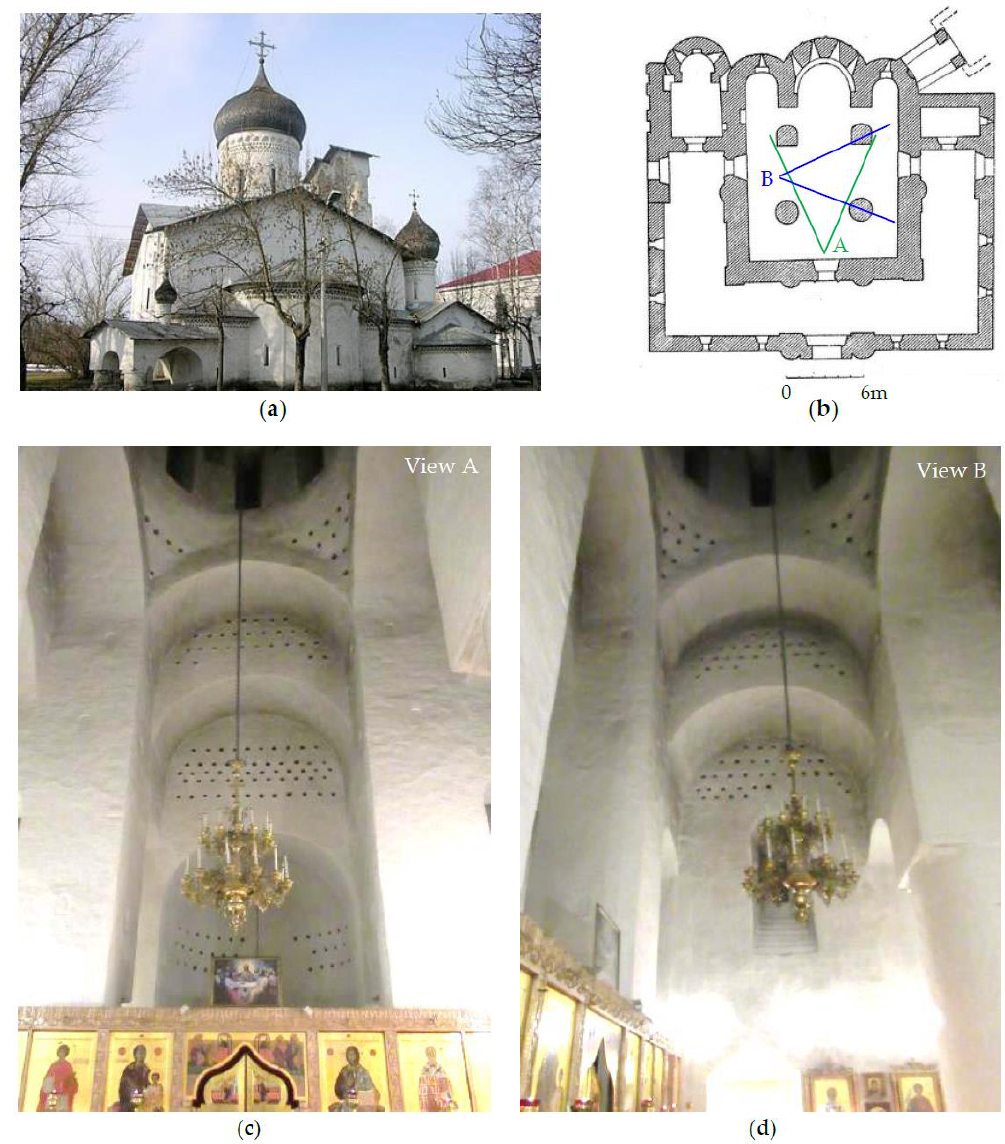
Figure 4. Church Nikoly so Usokhi (St. Nicholas from the Dry Place), constructed in1535, in Pskov: the eastern facade ( a ), the plan of the ground floor ( b ), the vessels in the pendentives, an apse and upper parts of walls ( c,d